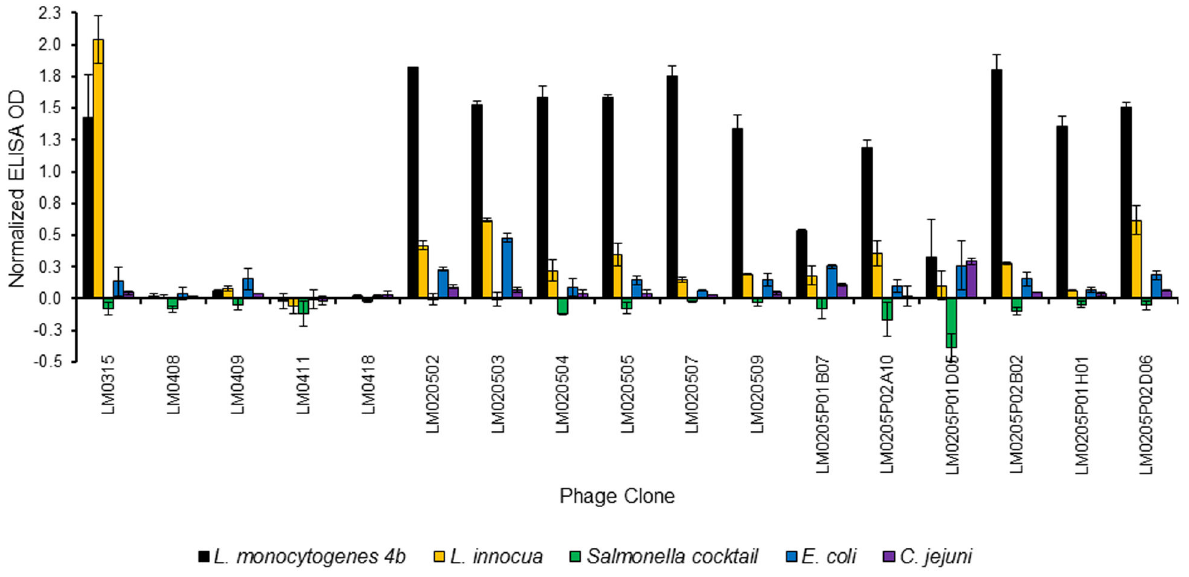
Figure 3. Phage binding ELISA specificity study for 17 selected phage clones from throughout the biopanning series. Normalized data equates to relative OD signal after subtraction of background OD signal. Experiment performed in duplicate (n=2). Error bars represent ± standard deviation of